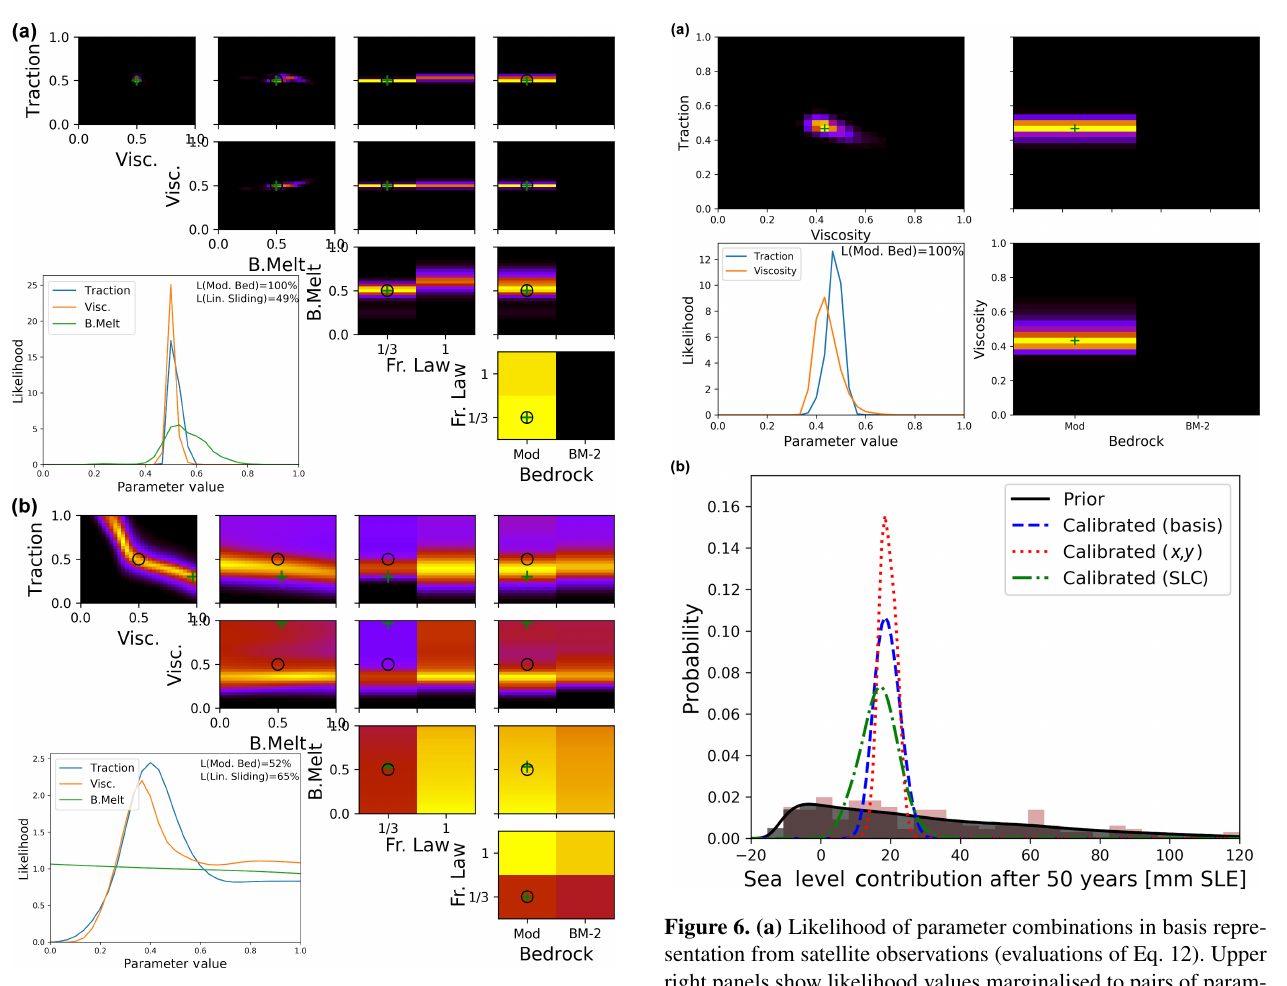
Figure 5. Likelihood of parameter combinations of the synthetic test case for reprojected emulator estimates (top, a ; Eq. 14) and sea level rise contribution calibration (bottom, b ; Eq. 15). Upper right panels show likelihood values marginalised to pairs of parameters including basal melt factor (B. Melt) and friction law exponent (Fr. Law), normalised to the respective maximum for clarity. Lower left panel shows likelihood values marginalised to individual parame- ters for the three scalar parameters (line plots), as well as the fric- tion law exponent and bedrock topography map (labelled as L(Lin. Sliding) and L(Mod. Bed) respectively), normalised to an integral of one, consistent with probability density functions. The central values for traction, viscosity, and ocean melt as well as non-linear friction and modified bedrock are used. The parameter values are also shown by the black circles, while the values of the set of pa- rameters with highest likelihood are shown by green crosses.